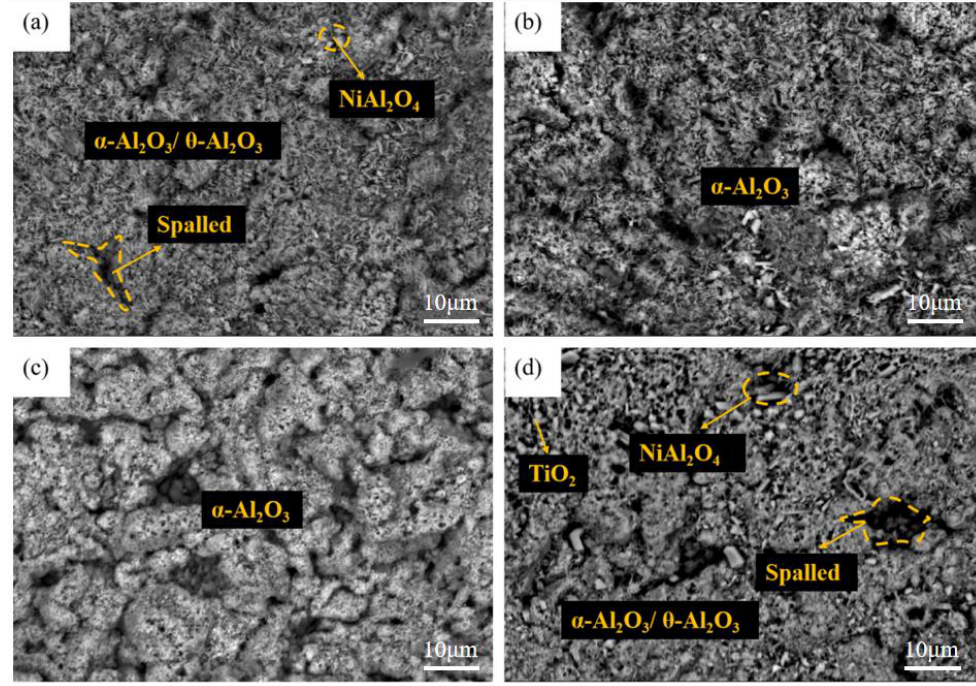
Figure 18. Surface morphologies of Al-Si coatings oxidized at 1000 °C for 300 h under different pre- oxidation times: ( a ) 3 h; ( b ) 5 h; ( c ) 7 h; ( d ) 9 h.